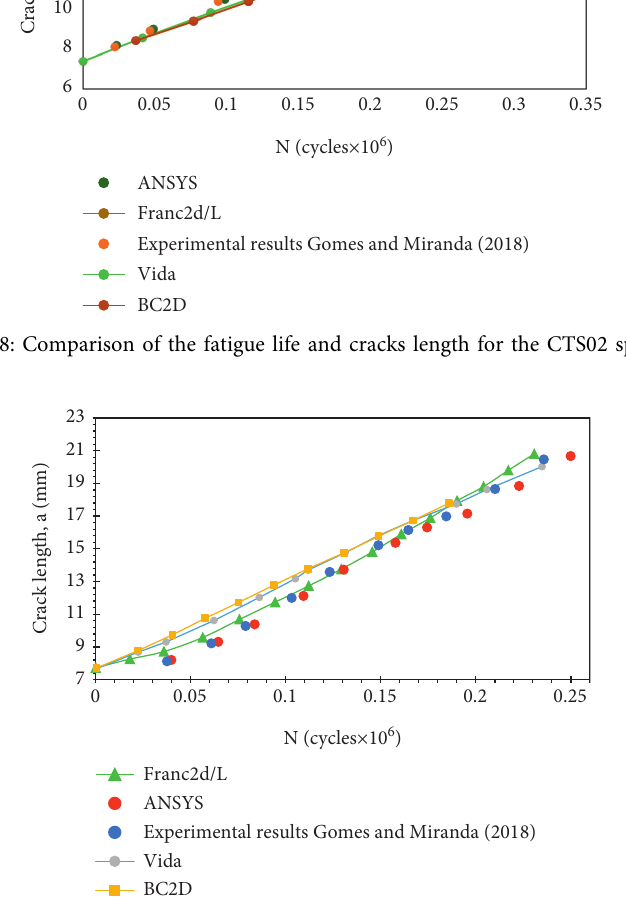
Figure 19: Comparison of the fatigue life and cracks length for the CTS03 specimen.